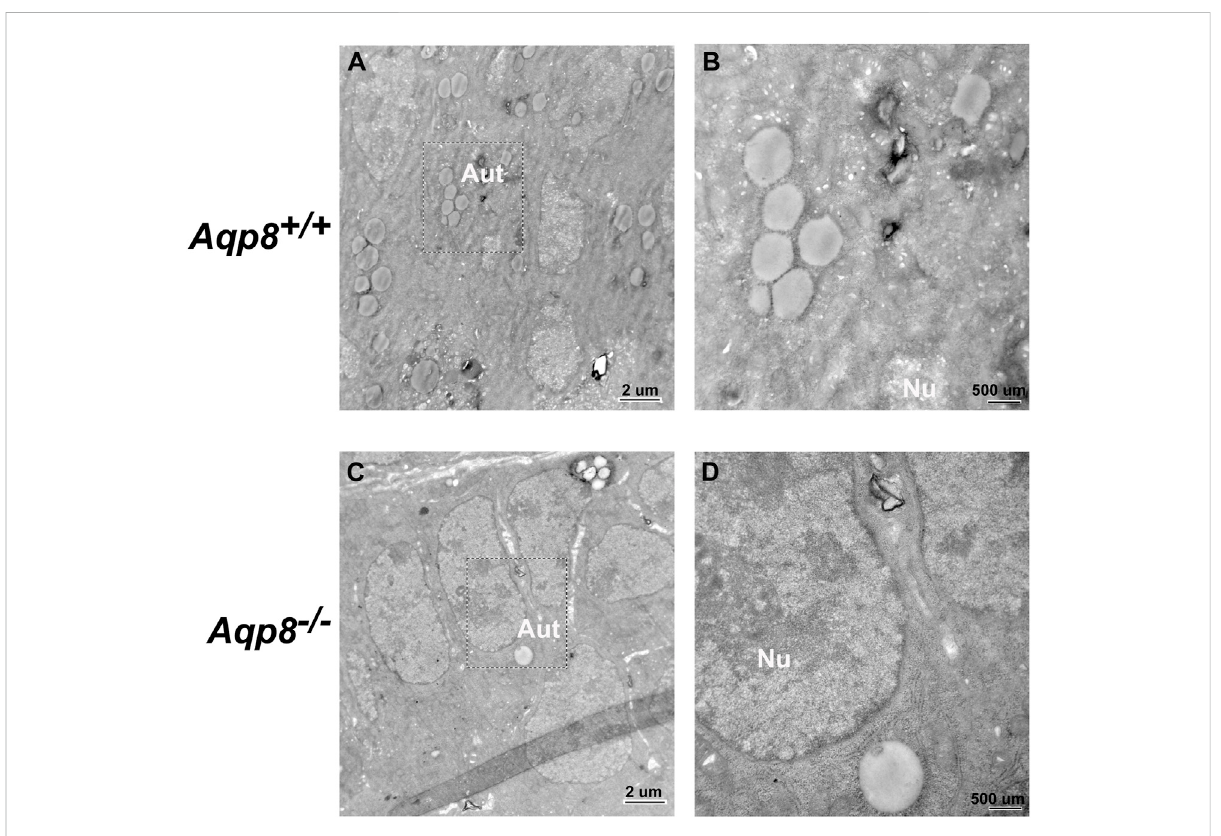
FIGURE 2 Transmission electron microscopic images of granulosa cells in Aqp8 +/+ and Aqp8 − / − mice. Representative images from transmission electron microscopy of granulosa cells from Aqp8 +/+ (A,B) and Aqp8 − / − (C,D) mice. High-magni fi cation images indicated nucleus (Nu) and autophagosomes (Aut). The scale was indicated on the lower right corner of each image.